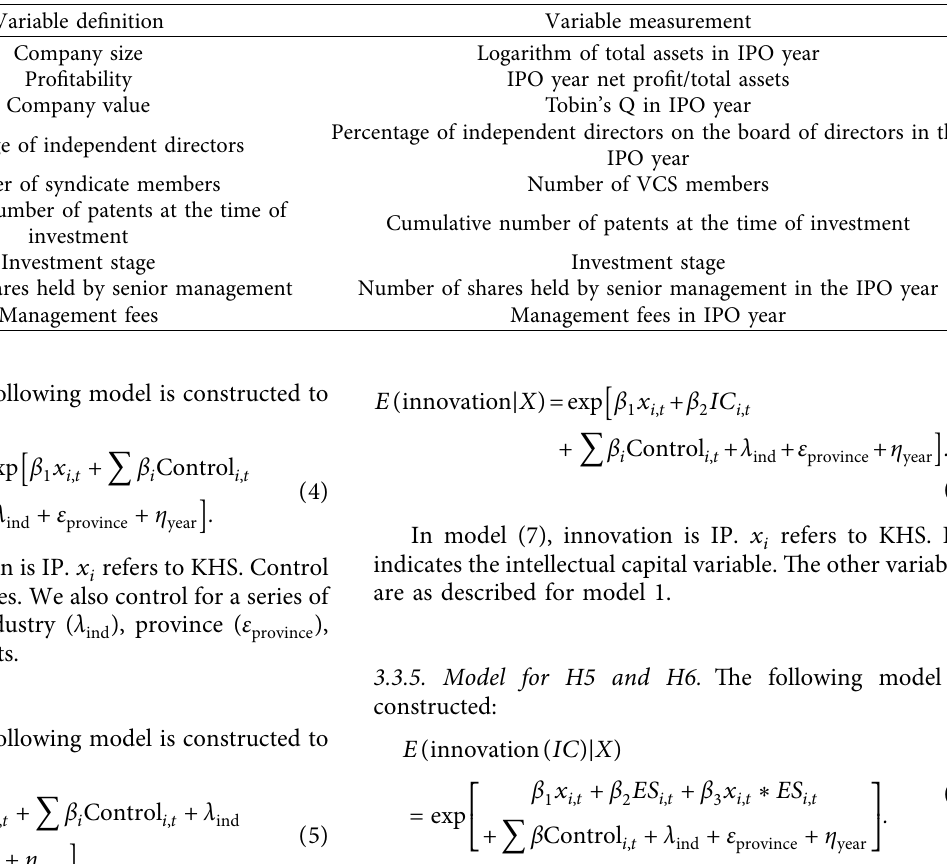
Table 2: Descriptive analysis of controlling